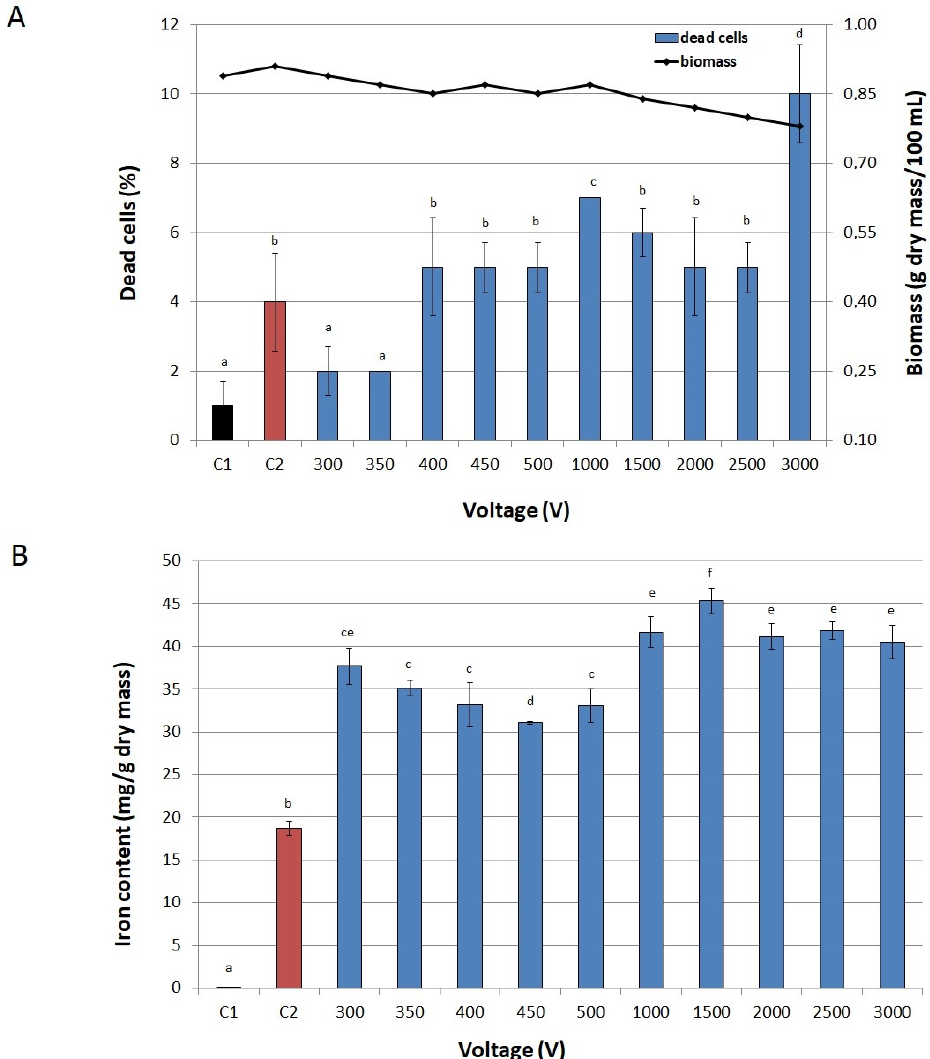
Figure 3. Effect of voltage on viability of cells and biomass ( A ) and on iron accumulation in yeast cells ( B ). C1—control culture without iron ions added to the medium and PEF treatment, C2—control culture with iron ions added to the medium (200 µ g/mL) and without PEF treatment, blue bars— cultures treated with PEF (ferric nitrate, 200 µ g Fe 3+ /mL, pulse width of 10 µ s, treatment time 10 min, number of pulses 600, after 20 h of cultivation). Each value is the mean ± standard deviation ( n = 3). Bars with the same letter (a–f) are not significantly different ( p < 0.05).